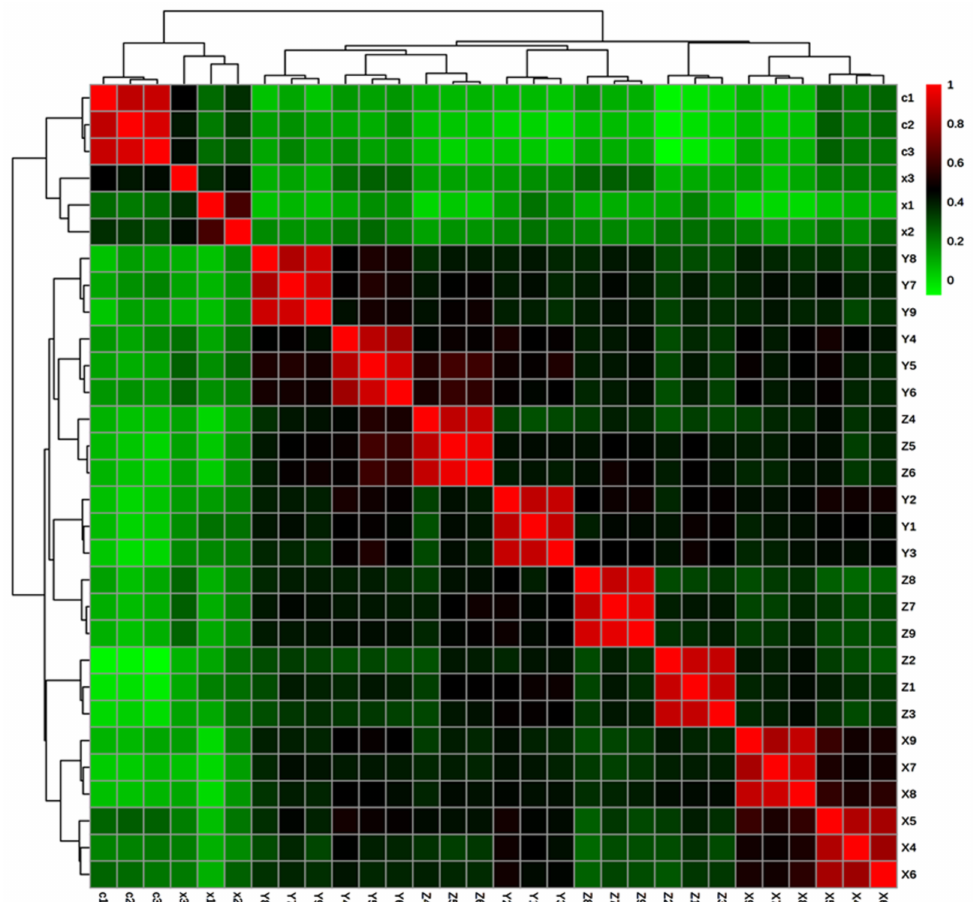
Figure 10. Correlation plot with dendrogram showing the grouping of SA stressed seedlings using Pearson’s